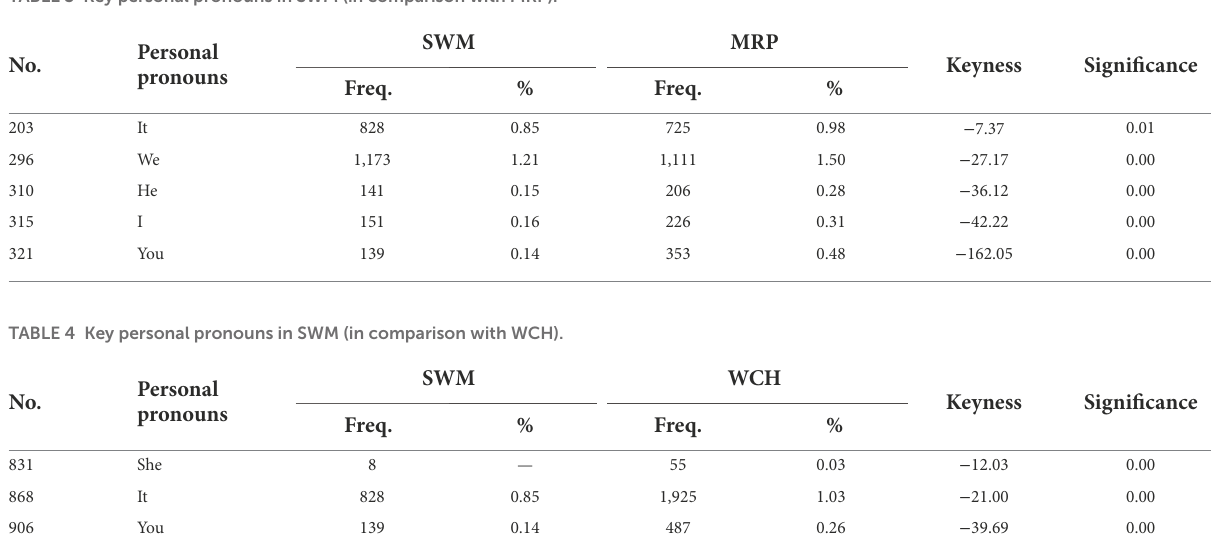
TABLE 3 Key personal pronouns in SWM (in comparison with MRP).